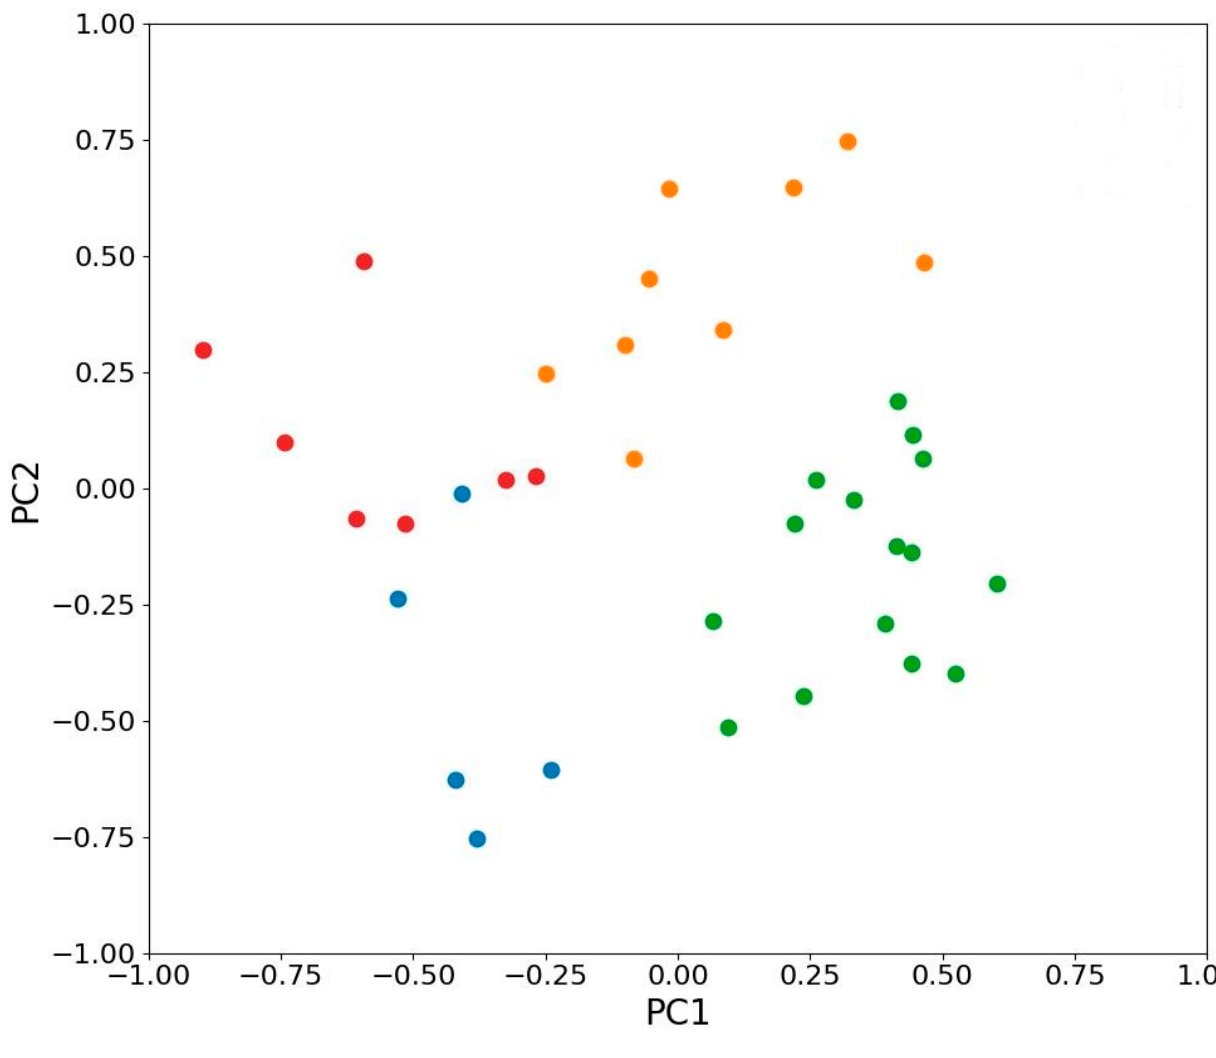
Figure 10. K-means clustering of PCA representations of studied leaves of H. morsus-ranae. The leaves were automatically assigned to different clusters (shown in different colors), that are similar to groups by their age and lighting conditions.